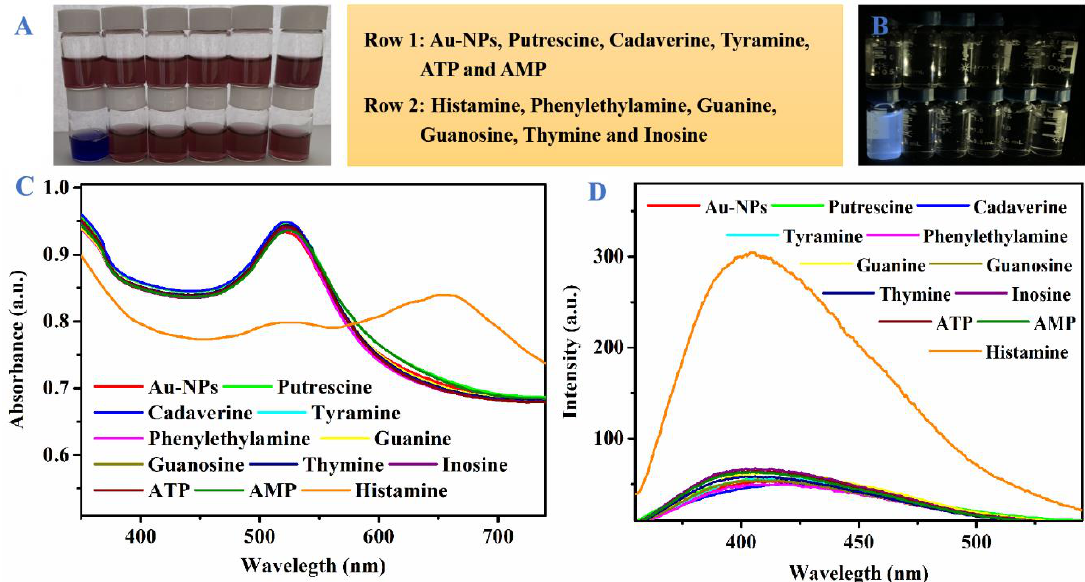
Figure 4. ( A ) colorimetric, ( B ) fluorescent response, ( C ) UV-vis spectra and ( D )fluorescence spectra of Au-NPs added with different biological substances containing amino groups (histamine, putrescine, cadaverine, tyramine, phenylethylamine, guanine, guanosine, thymine, inosine, ATP, and AMP) at concentrations of 1.0 μM.